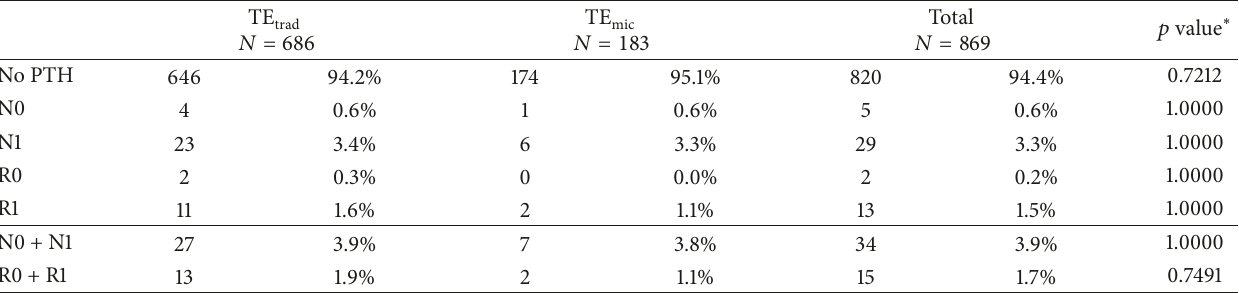
Table 3: PTH rates stratified by postoperative time (0: on the day of surgery, 1: after the day of surgery) and the need for a surgical control (N: no return to theater, R: return to theater). 𝑝 values are calculated by Fisher’s exact test.